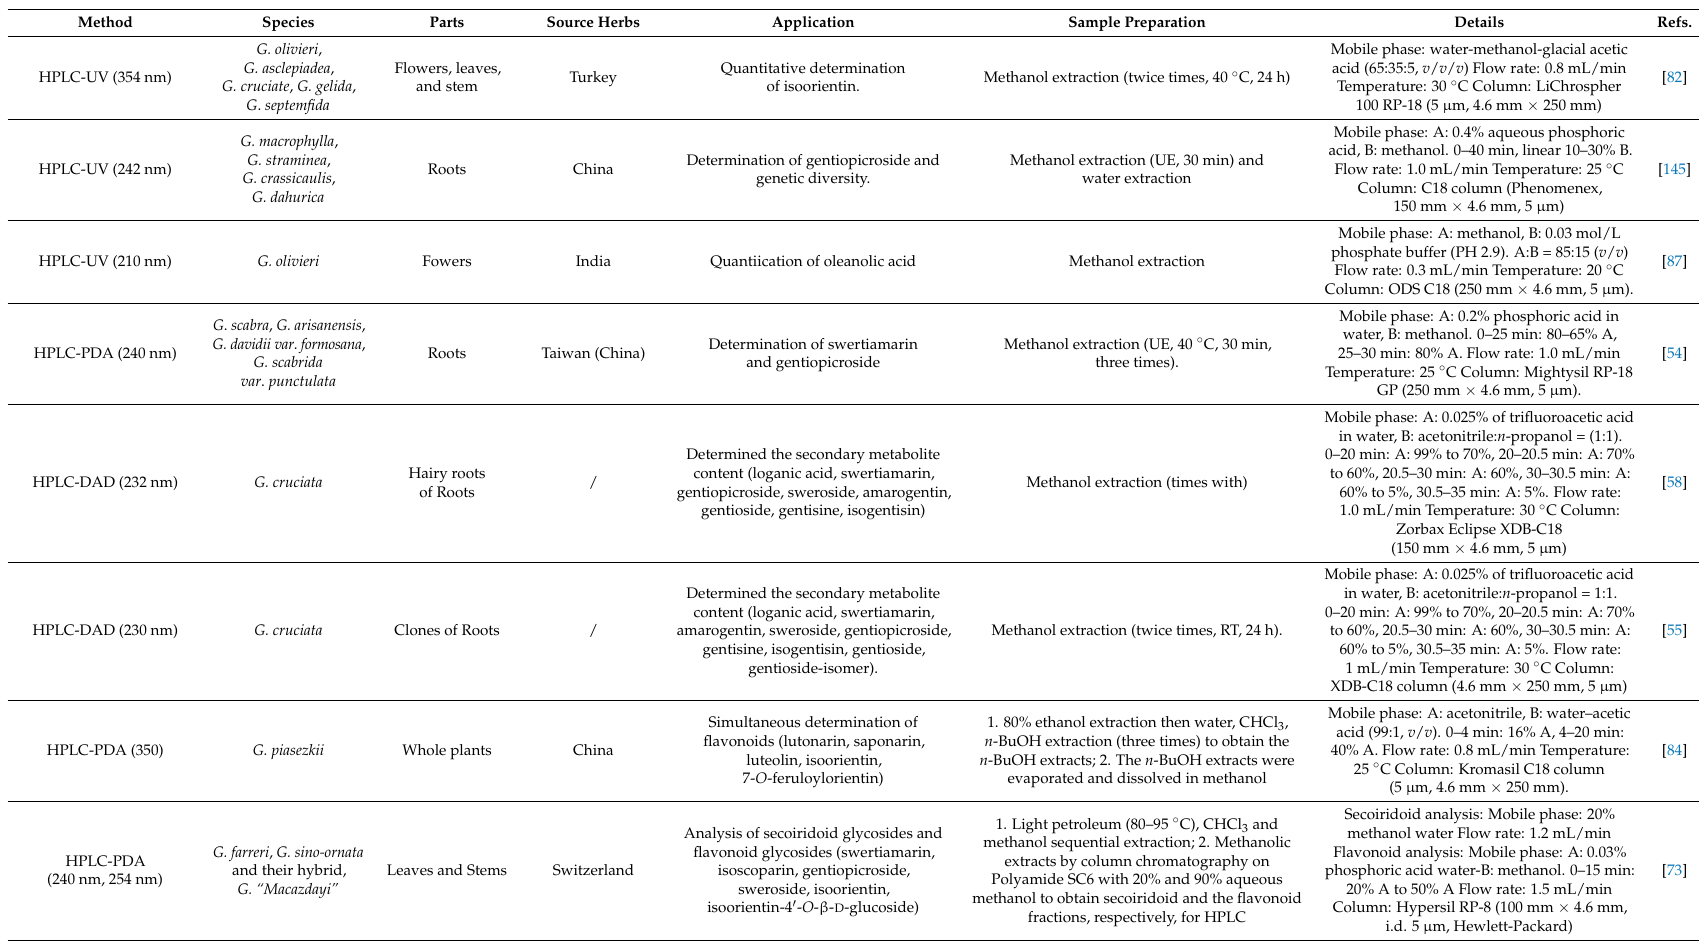
Table 4. Cont. Sample Preparation Details Refs.